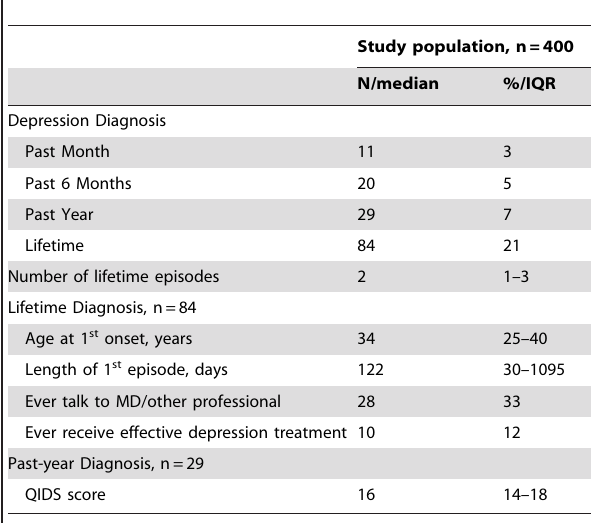
Table 2. Prevalence of depression diagnoses (N, % or median,